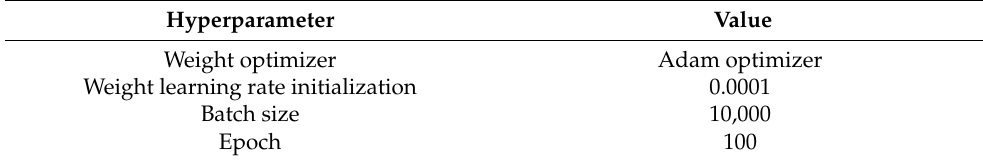
Table 2. Hyperparameters settings in training